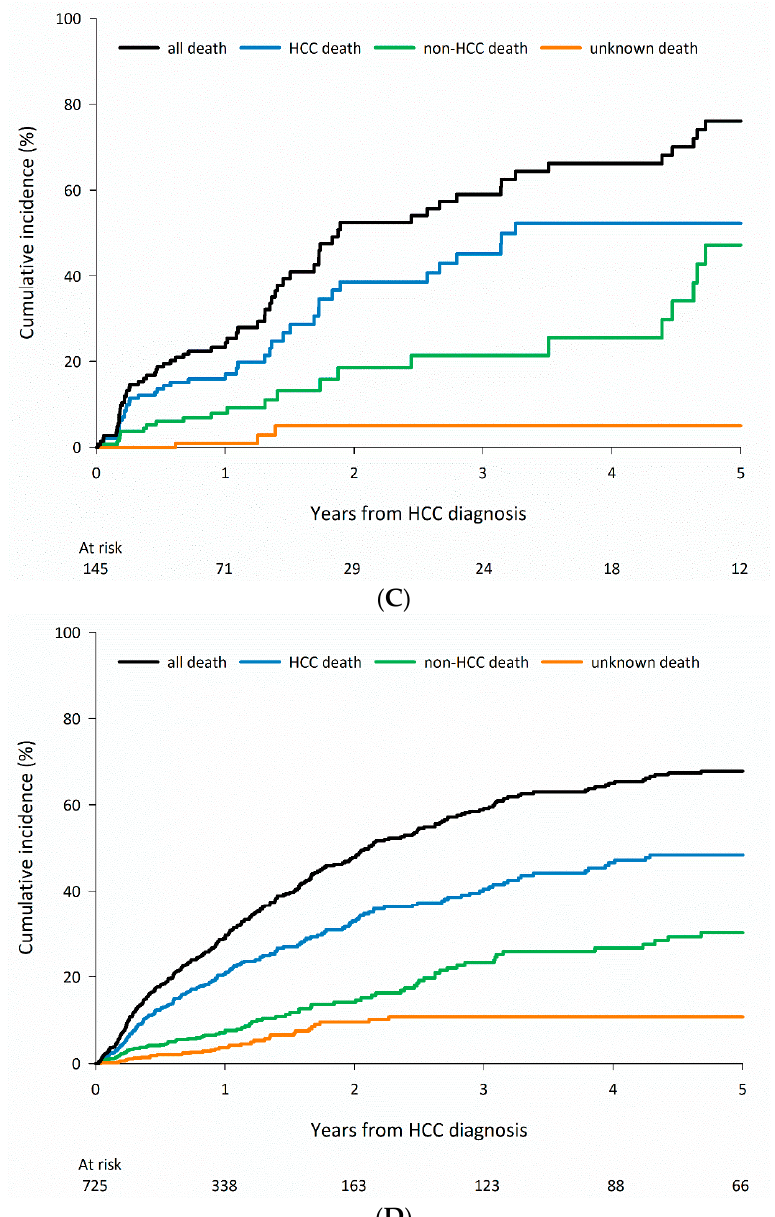
Figure 1. Cumulative mortality risk for hepatocellular carcinoma according to chronic liver disease etiology: ( A ) hepatitis C virus; ( B ) hepatitis B virus; ( C ) alcohol use; and ( D ) all negative (defined as no evidence of virus infection or alcohol use). Table 2. Cause-specific mortality among all patients.